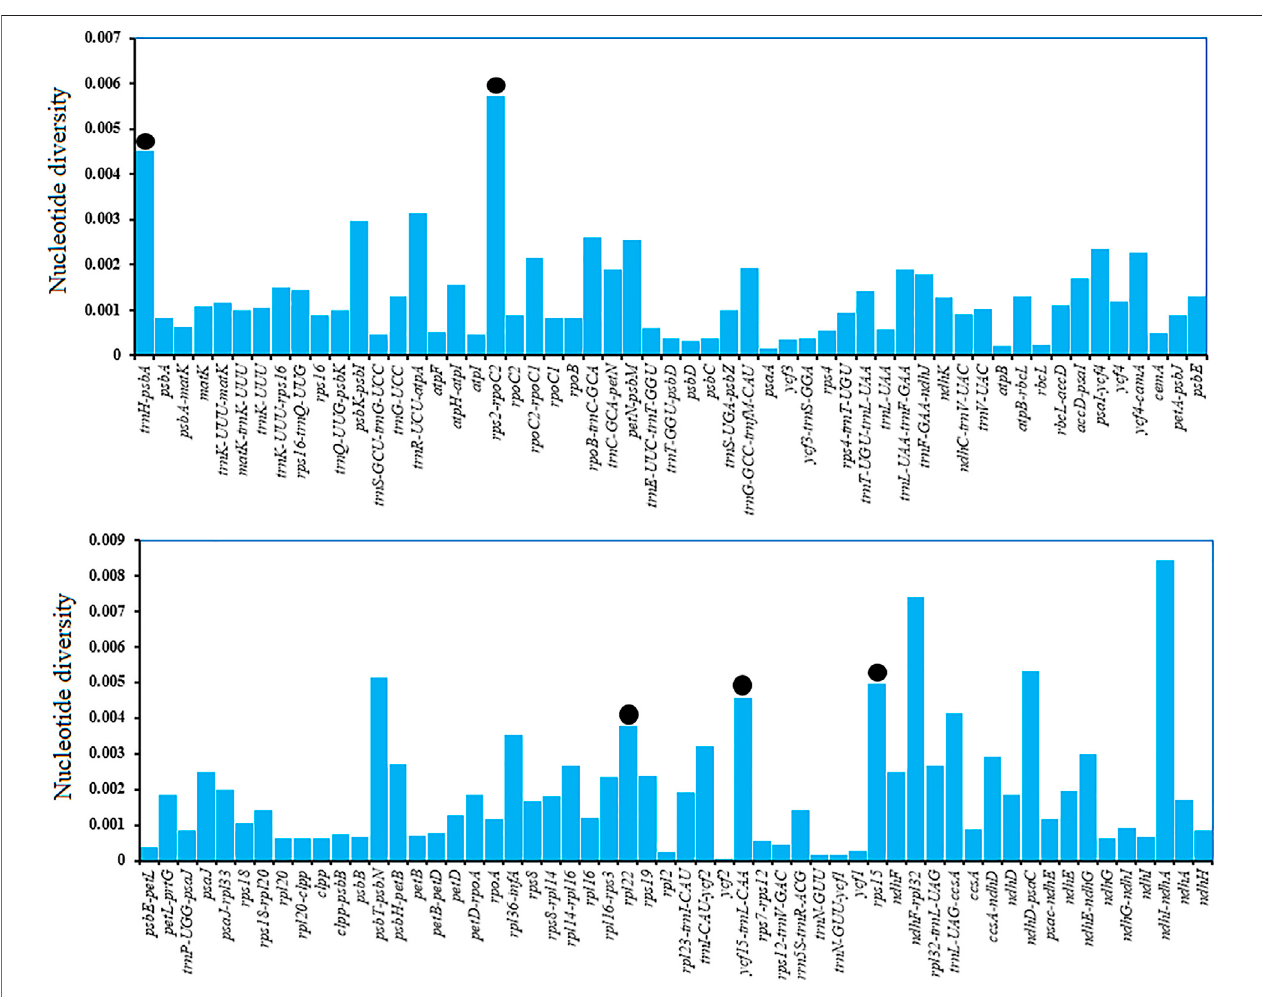
FIGURE6| Extentofpolymorphisminallplastidregions.Regionswithnonucleotidediversitywereexcludedandarenotshownhere.Theblackcircleindicatesthe fi ve suitable polymorphic loci with a length > 200 bp. The x -axis shows plastid regions, and the y -axis shows nucleotide diversity.